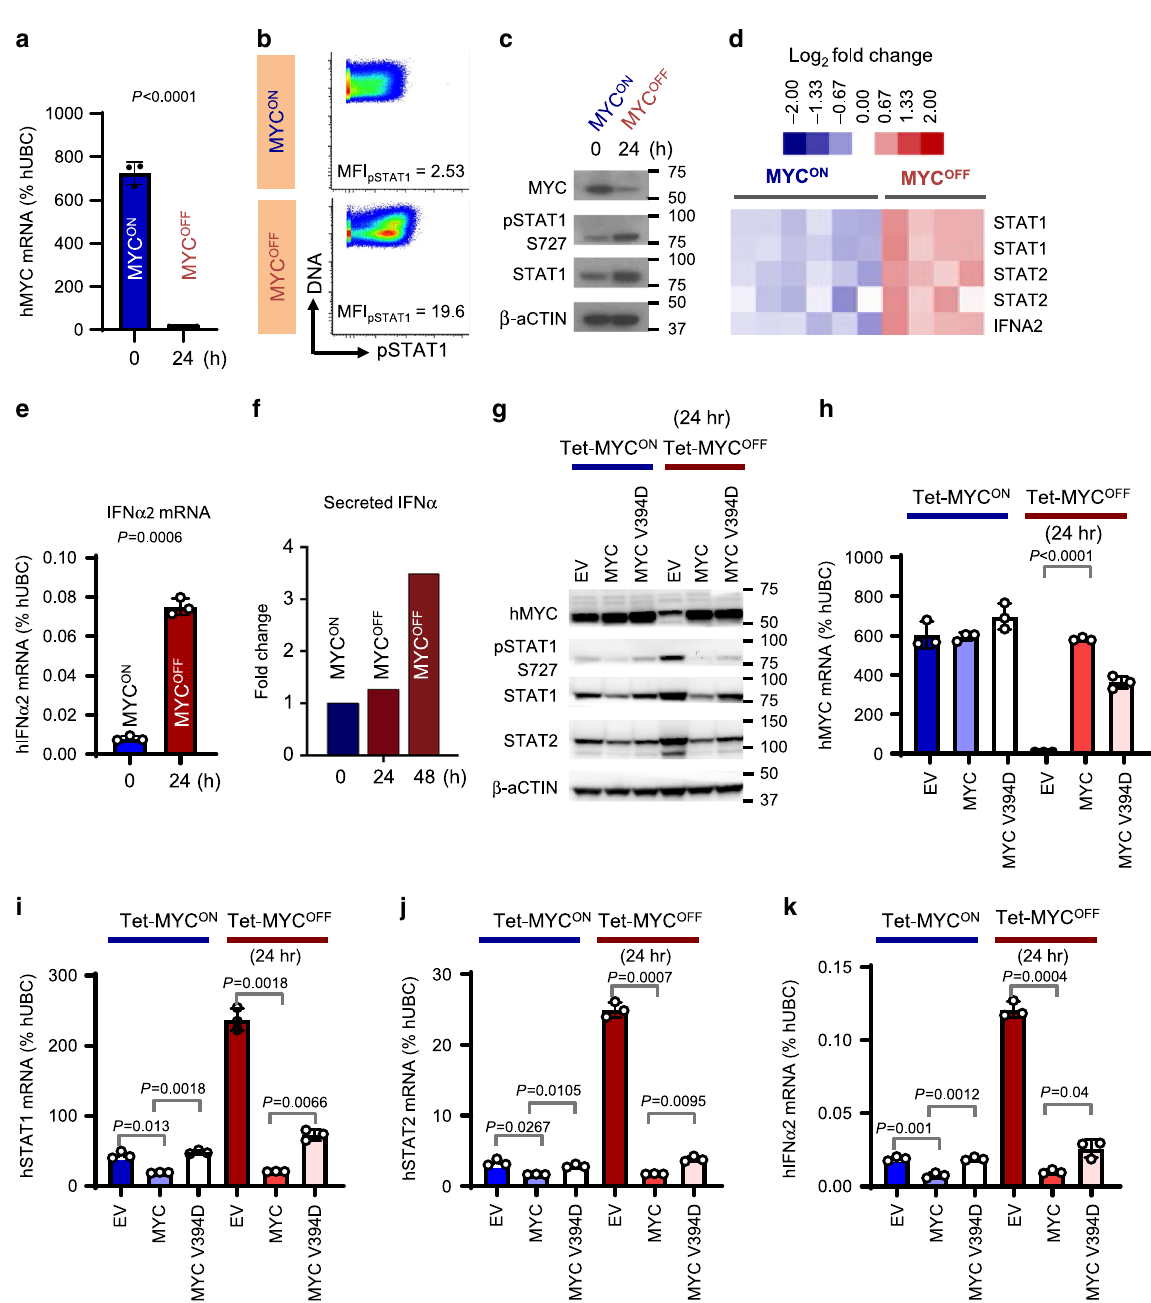
Fig. 5 MYC transcriptionally represses the STAT1/2-Type I IFN signaling associated with NK cell maturation. a Quantitative real-time PCR for MYC in P493-6 BL human cells before and after MYC inhibition for 24 h by doxycycline ( n = 3, mean ± s.d.). b Phospho mass cytometry (Phospho-CyTOF) depicting changes in pSTAT1 levels before ( MYC ON ) and after ( MYC OFF ) MYC inactivation for 24 h in P493-6 cells. c Immunoblotting to validate changes in pSTAT1 observed by phospho-CyTOF. d Heatmap depicting transcriptional changes in STAT1/2-Type I IFN signaling cascade before ( MYC ON , n = 6) and after MYC inactivation ( MYC OFF , 24 h, n = 4) in P493-6 cells using expression arrays. e Quantitative real-time PCR for Type I IFN α 2 in P493-6 BL human cells before and after MYC inactivation for 24 h by doxycycline ( n = 3, mean ± s.d.). f Luminex assay depicting changes in Type I IFN α 2 secreted from P493-6 cells before and after MYC inactivation for 24 and 48 h. Each time point was carried out in duplicates. Average of these duplicates is shown. g Immunoblotting in P493-6 BL cell lines expressing empty vector (EV), MYC overexpression vector (MYC), or a MYC mutant that fails to bind MIZ1 ( MYC V394D ), pre- ( Tet-MYC ON ) and post ( Tet-MYC OFF ) MYC inactivation. h – k Quantitative real-time PCR for MYC ( h ), STAT1 ( i ), STAT2 ( j ) and Type I IFN α 2 ( k ) in P493-6 BL cell lines expressing empty vector (EV), MYC overexpression vector (MYC), or a MYC mutant that fails to bind MIZ1 (MYC V394D), pre- ( Tet-MYC ON ) and post ( Tet-MYC OFF ) MYC inactivation ( n = 3, mean ± s.d.). All p -values have been calculated using two-tailed Student ’ s t -test. ns not signi fi